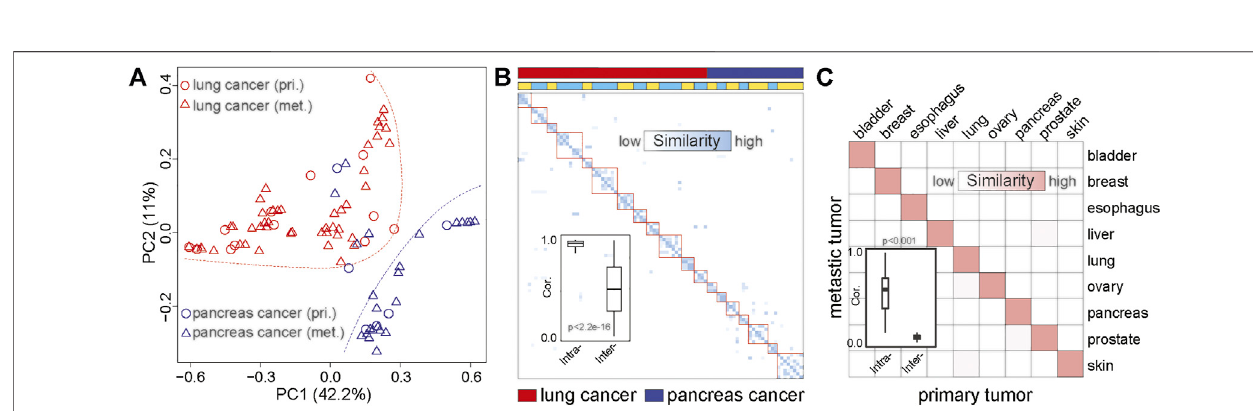
FIGURE 3 | The similarity between metastatic and primary tumors based on MS. (A) PCA based on the MS of matched primary and metastatic cancers. The red dots represent the primary lung cancer, the red triangles represent metastaticlung cancer, the blue dots represent the primary pancreatic cancer, and the blue triangles represent metastatic pancreatic cancer. The red dotted line indicates the distribution area of lung cancer, and the blue dotted line indicates the distribution area of pancreatic cancer. pri., primary cancer; met., metastatic cancer. (B) The similarity between primary cancer and metastatic cancer based on MS. The darker the color, the higher the similarity. The fi rst line indicates the tumor type. Red represents lung cancer, and blue represents pancreatic cancer. The second line shows the origin of the sample. The same color indicates that the sample is from the same patient. (C) The correlation between primary and metastatic cancer based on MS in common cancer. Thedarker thecolor, thehigher the similarity.Theboxplot shows thesimilarity betweentheprimary and metastatic tumorsofthe sametumor type and the similarity between the primary and metastatic tumors among different tumor types.